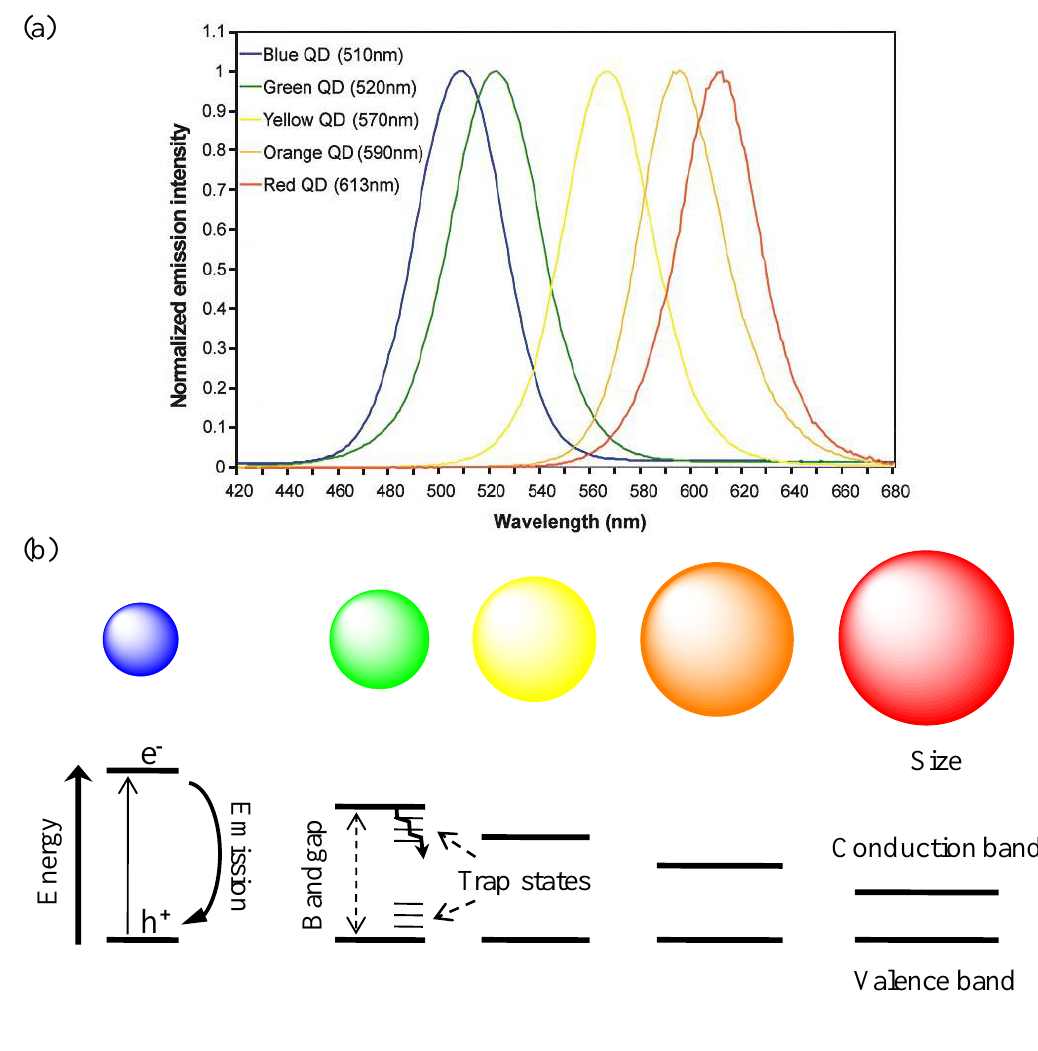
Figure 1 . (a) Emission spectra of CdSe/ZnS QDs (water-soluble QDs excited at 350 nm) (Reprinted with permission from Macmillan Publishers Ltd., Nature Biotechnology [7], Copyright 2002); (b) Illustration of size-tunable QDs and creation of the exciton